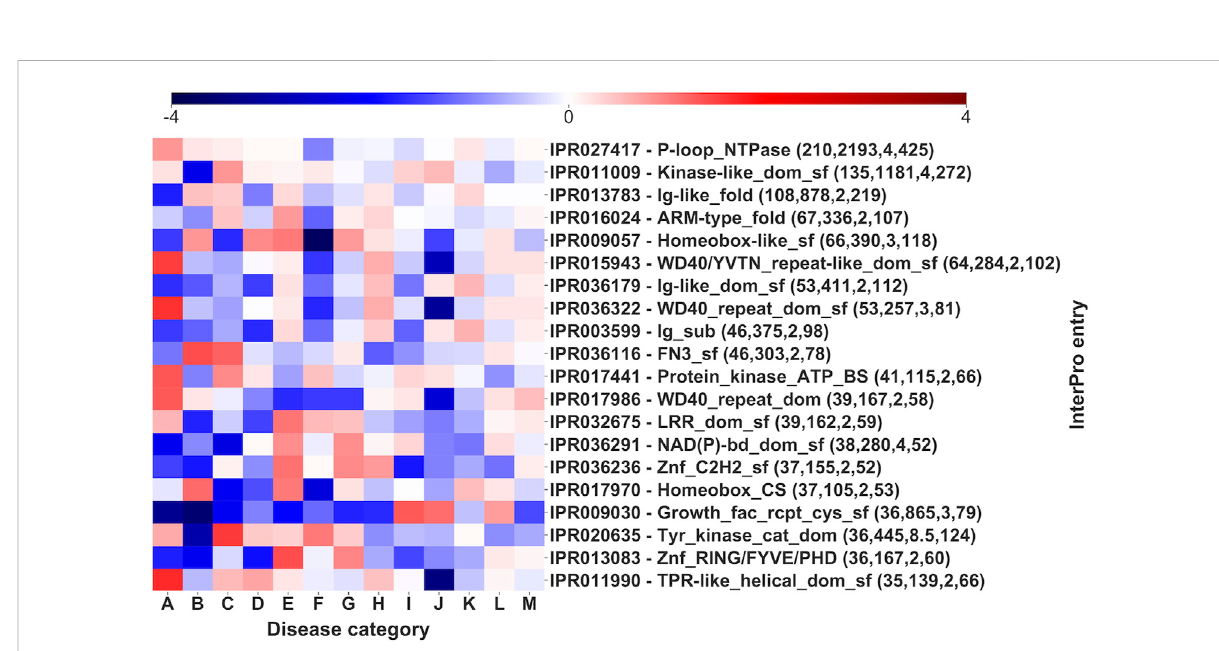
FIGURE 8 Log-odd scores for disease categories associated to different InterPro domains. Log-odds are calculated with respect to the whole-dataset background of disease categories (Supplementary Table S4). Numbers in parentheses report the number of genes, of SRVs, the median number of SRVs per gene and the number of diseases (for statistical validation see Supplementary Table